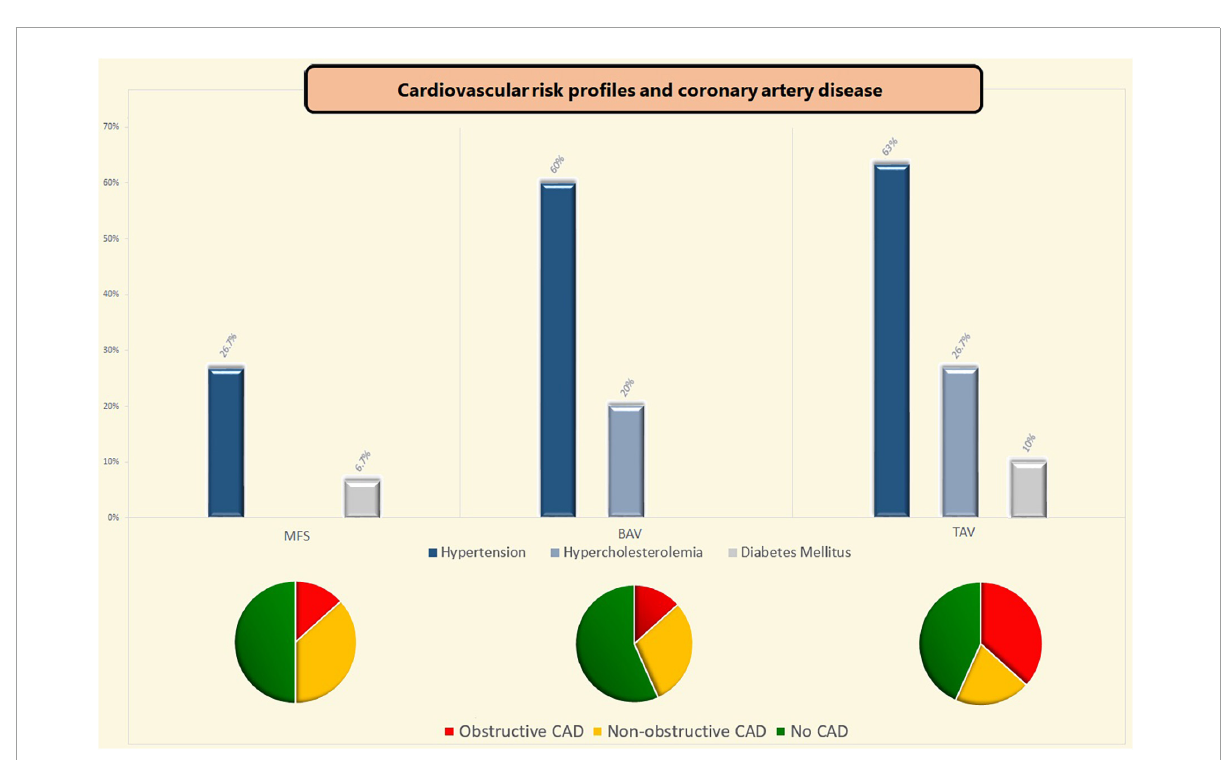
FIGURE2 Coronary artery disease and cardiovascular risk profiles. BAV, bicuspid aortic valve; CAD, coronary artery disease; MFS, Marfan syndrome; TAV, tricuspid aortic valve.